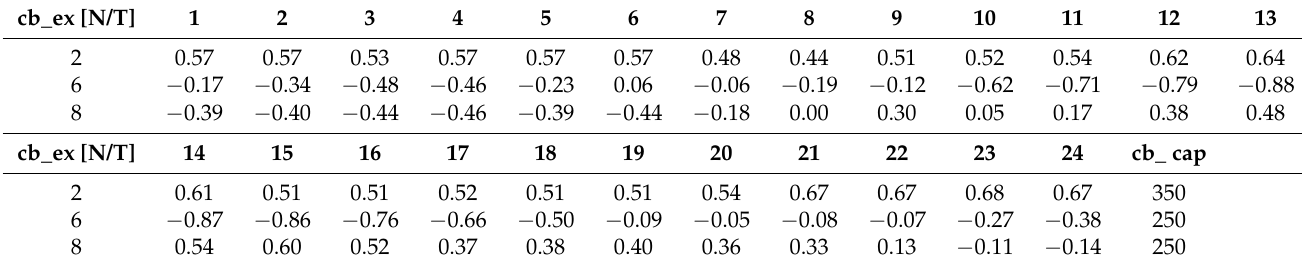
Table A1. Table representing crossboarder exchange profile cb ex and crossboarder exchange capacity cb cap .